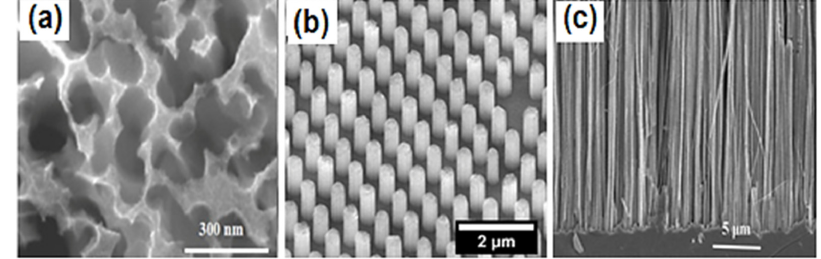
Figure 2. Scanning electron microscopy images of PSi ( a ) [4], SiNPs ( b ) [10], and SiNWs ( c )